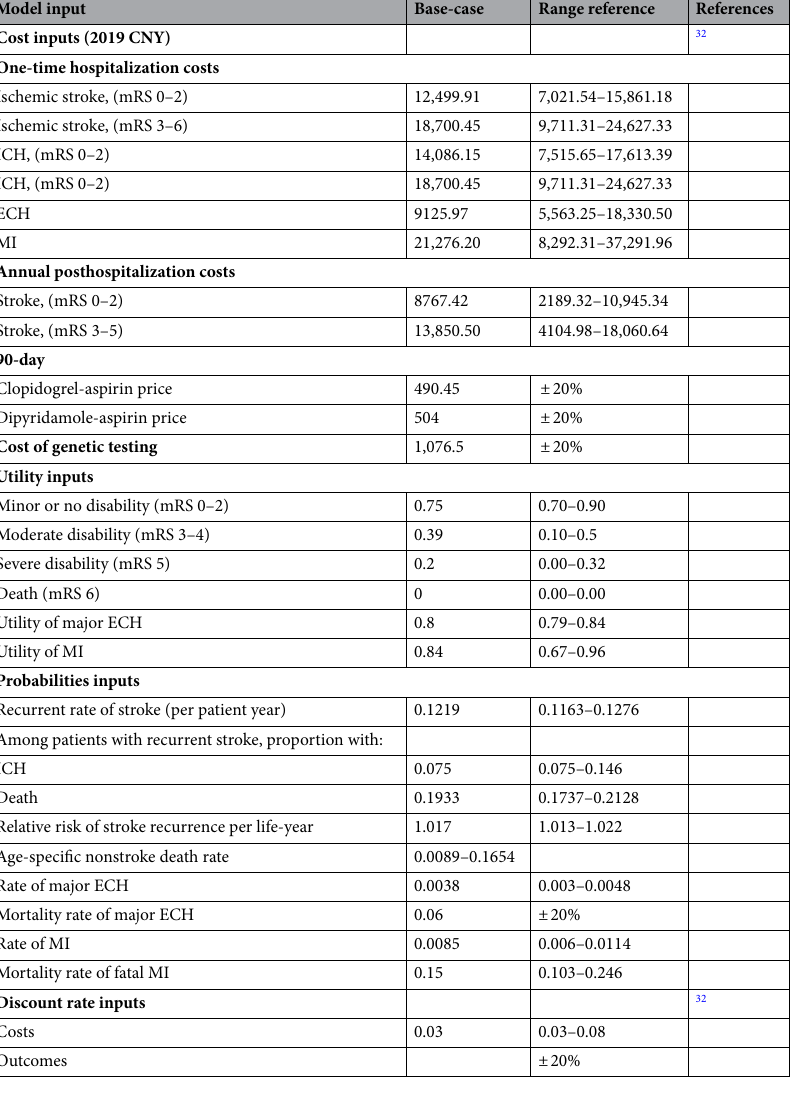
Table 3. Model Parameters and the Range of Values Tested in Sensitivity Analyses. CNY Chinese Yuan Renminbi, ICH intracerebral hemorrhage, ECH extracranial hemorrhage, MI myocardial infarction, mRS modified Rankin